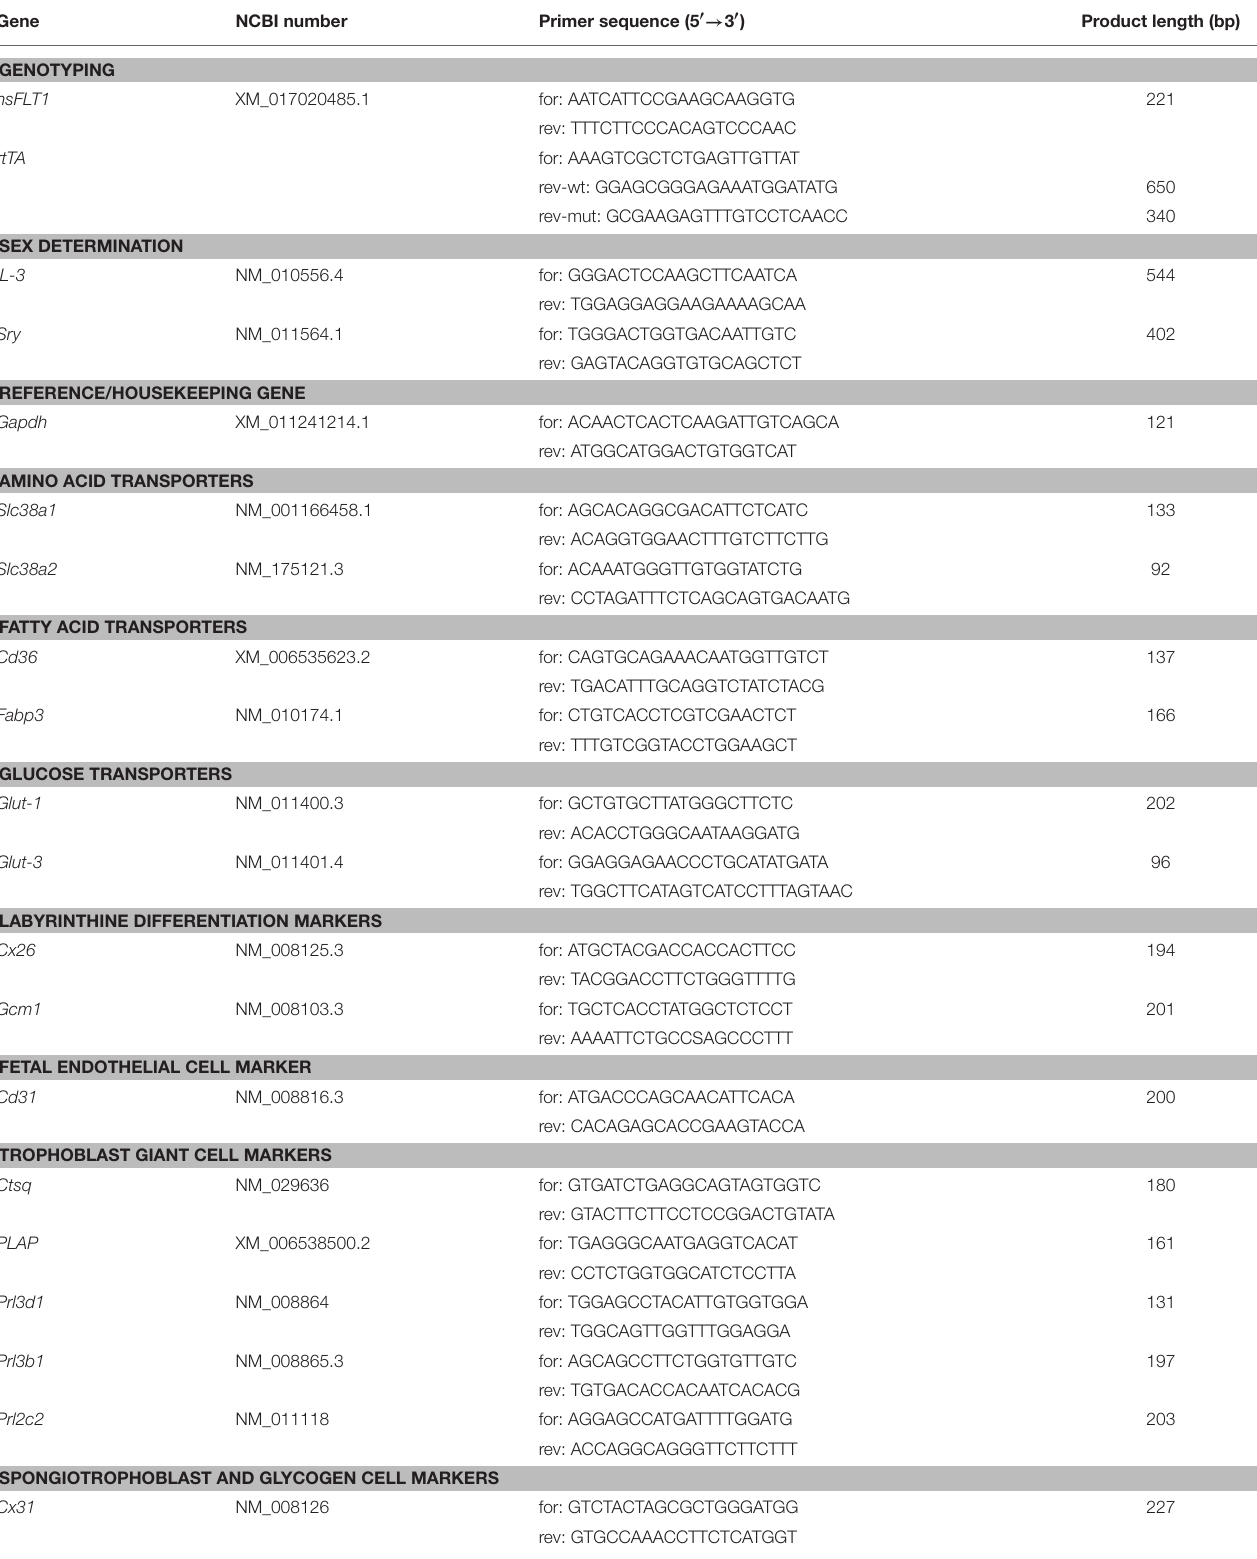
TABLE 2 | Oligonucleotides used for genotyping, sex determination and gene expression analysis in hsFLT1/rtTA mouse model. Gene NCBI number Primer sequence (5 ′ → 3 ′ ) Product length